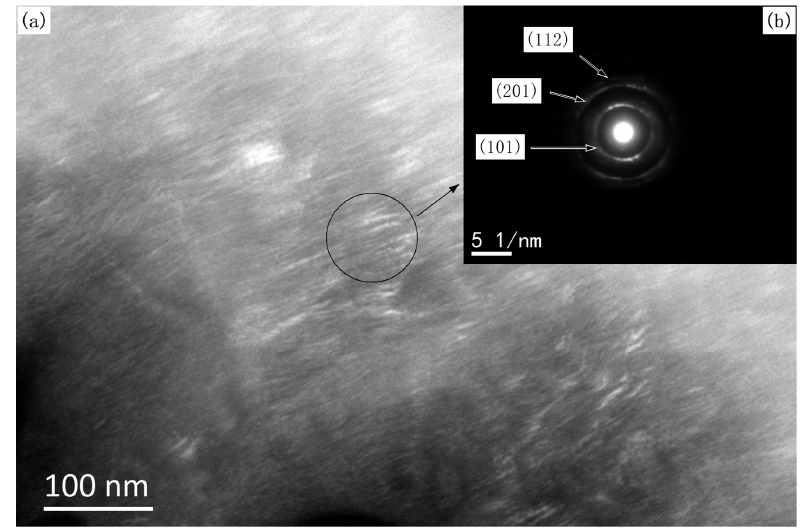
Figure 6. TEM images of the synthesized TiB 2 film formed by CVD with a TiCl 4 /BCl 3 gas flow ratio of 1: ( a ) dark field image, ( b ) corresponding selected-area electron diffraction pattern.